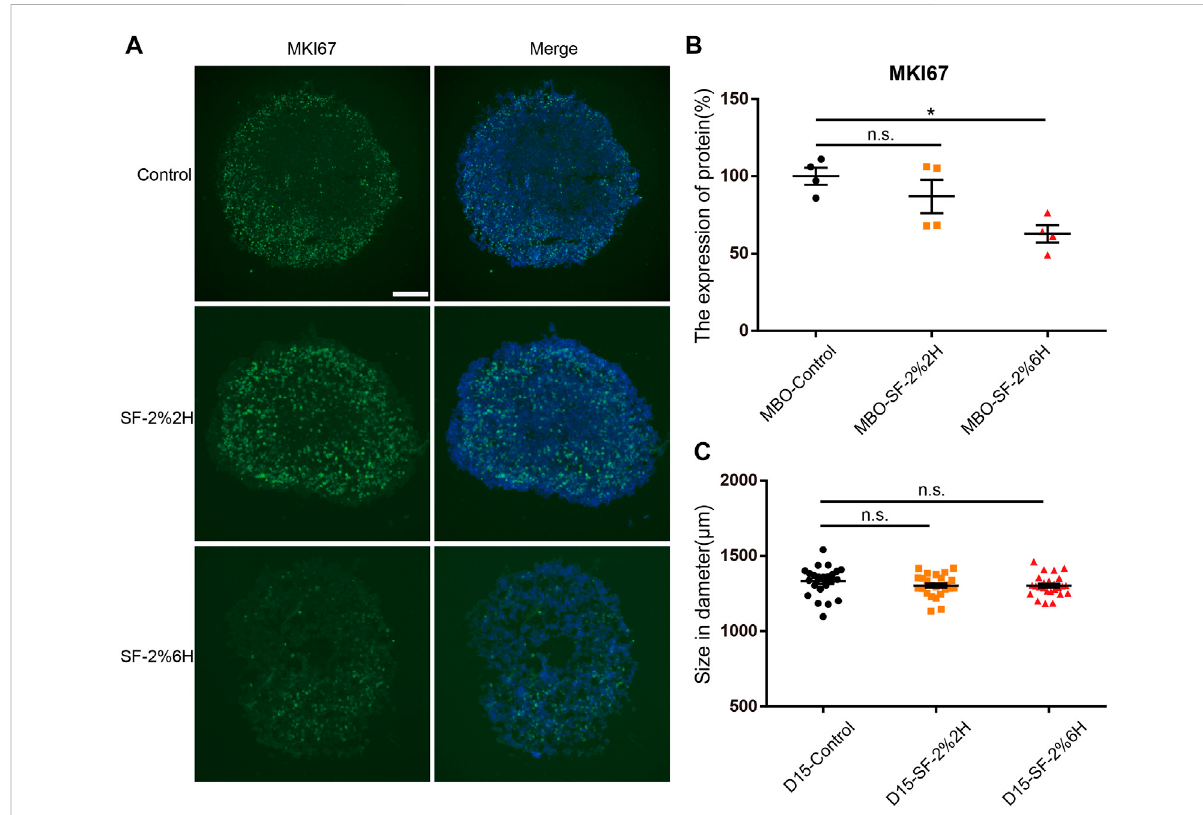
FIGURE 6 Sevo fl urane decreased the cell proliferation number of hMBOs. (A) Immuno fl uorescence staining for MKI67 (green) with DAPI (blue) in hMBOs. (B) Quanti fi cationof (A) (n=4). (C) DiameterofhMBOs(n=25).SampleimagesofhMBOsslicesweretakenusinganOlympusmicroscopeIX83.Data represent mean ± SEM. Scale bars represent 200 μ